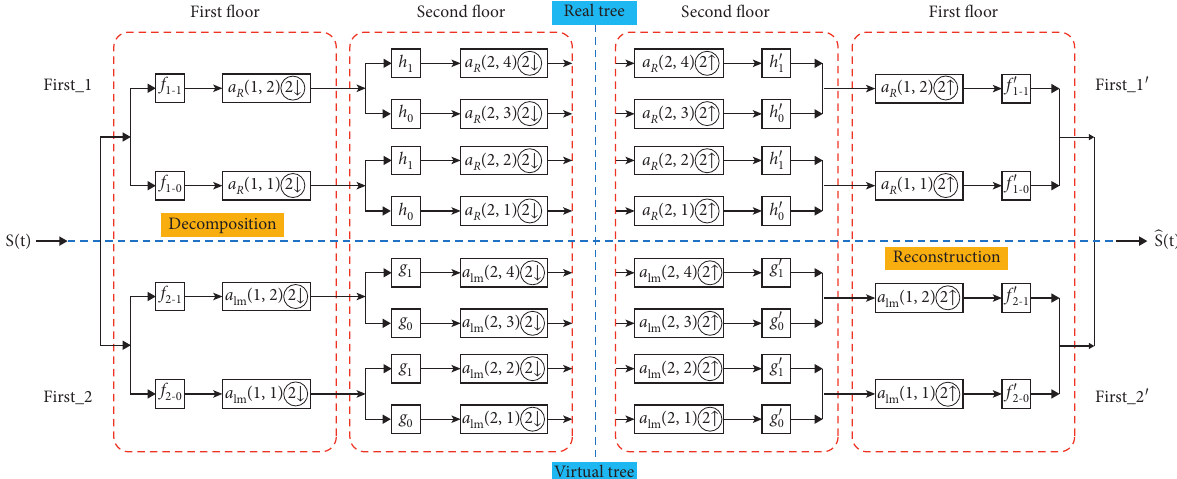
Figure 1: The decomposition and reconstruction process of